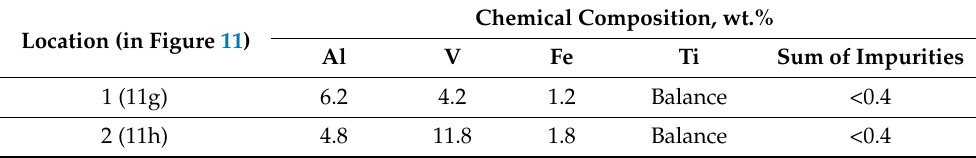
Table 3. Microanalysis EDS data of the areas within α -lamellae containing martensitic needles of two different